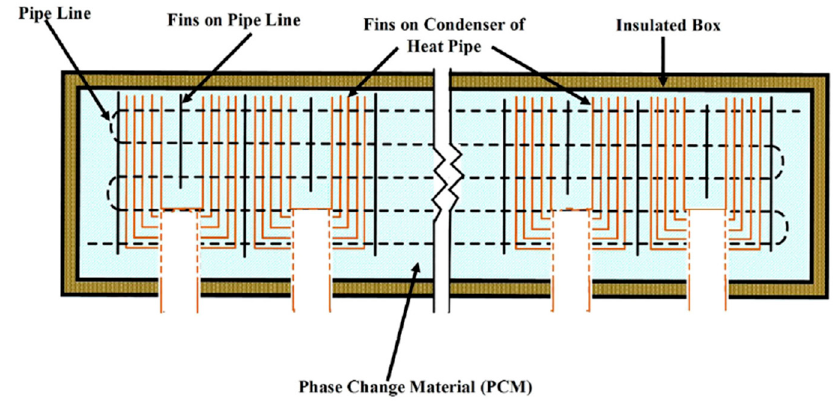
Figure 3. Design of phase change material integrated manifold [11].